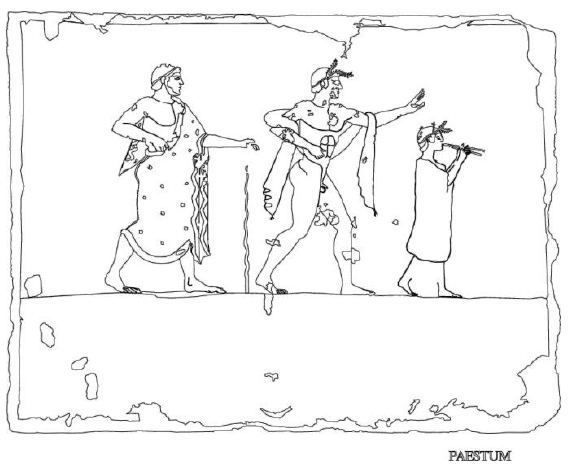
Figure 13. Color restitution of Diver’s Tomb Another slab of the sarcophagus, placed on the west side, represents a different scene with a procession open by a flute - player, followed by a man and a bearded and mantled old man, which leans himself on a stick. In the following figures the restitution and the color reproduction of this scene are shown.